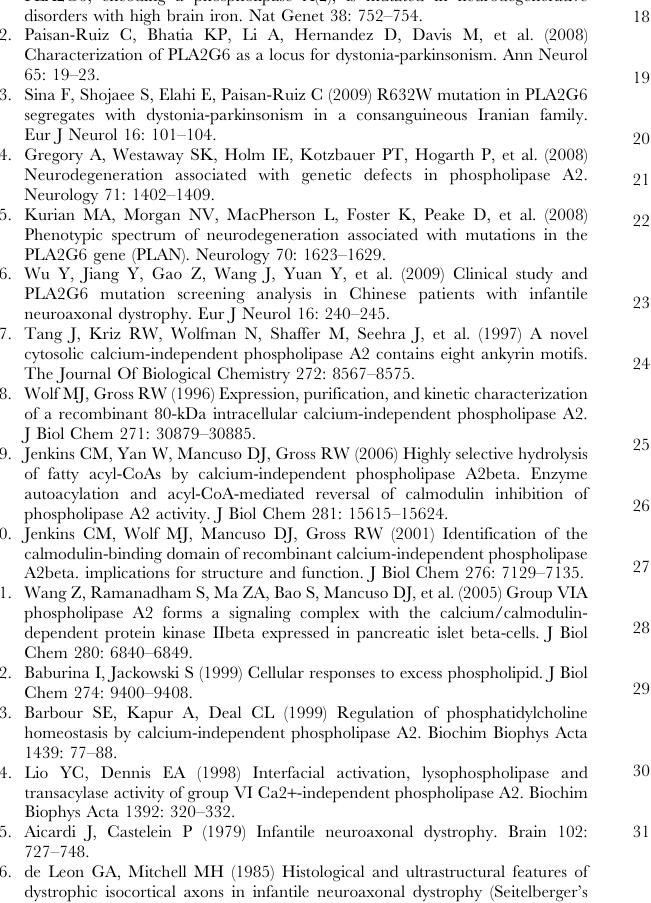
average luminescence of control lanes from vector transfected cells) and volume of WT PLA2G6 protein. Western blot analysis was used to determine the relative PLA2G6 protein concentration in each recombinant protein preparation and to normalize the amount of protein added to the catalytic assay as outlined in Material and Methods. Figure S3 Linear relationship between enzyme concentration and free fatty acid production in catalytic assays used to compare specific activities of WT and mutant PLA2G6 enzymes. Different amounts of WT enzyme were added to a catalytic assay with 14 C- labeled LPC. Released free fatty acids were separated on TLC and quantified by phosphorimager. The graph shows a linear relationship between enzyme concentration and fatty acid release. In experiments examining the effects of mutations associated with dystonia-parkinsonism, the amount of enzyme added to the assays was equivalent to 2 m l WT PLA2G6 enzyme in the above